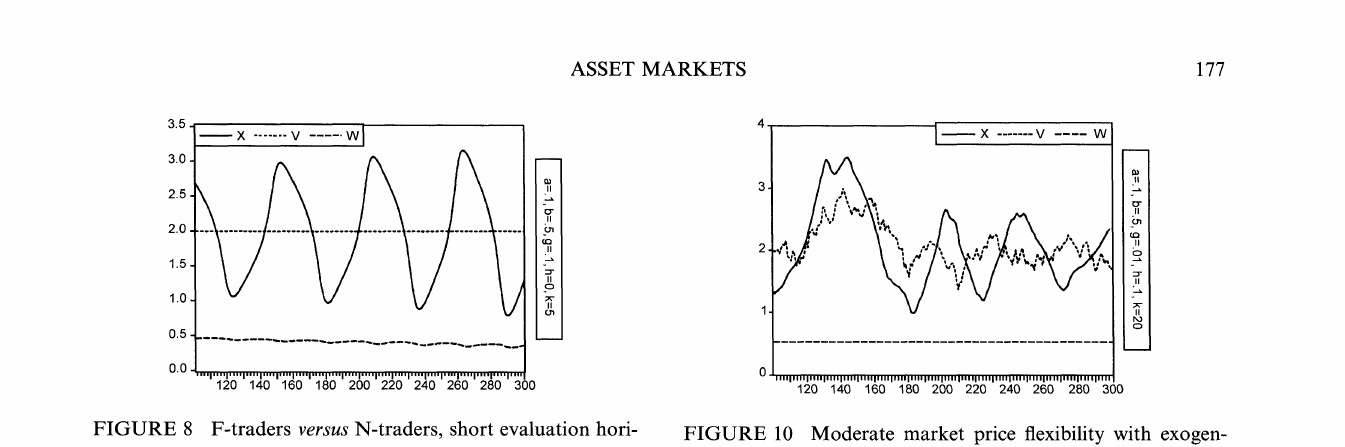
FIGURE 10 Moderate market price flexibility with exogen- ous noise.